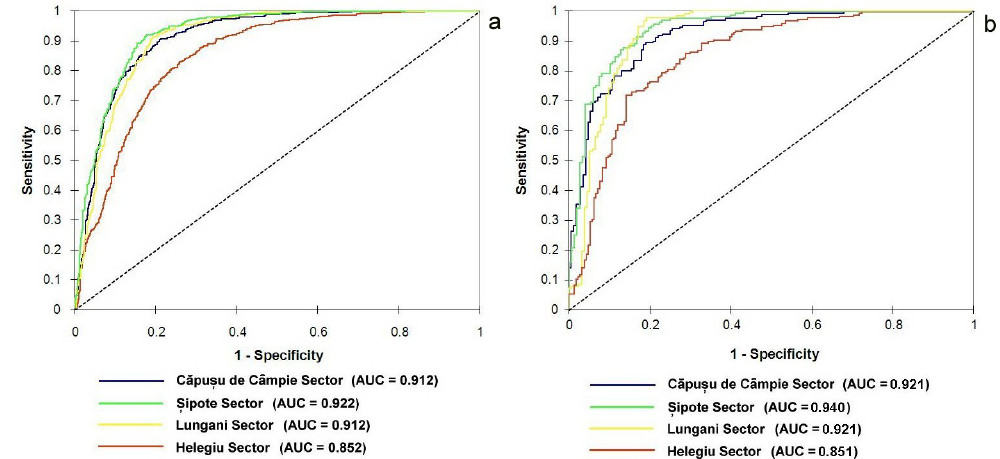
Fig. 10. ROC curves with associated AUC values computed from training samples (a) and validation samples (b) .